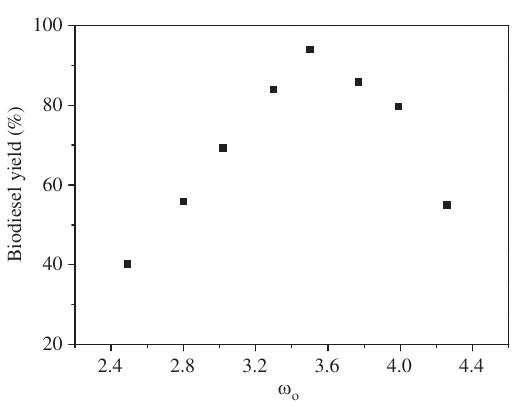
(molar ratio of water to surfactant) on biodiesel Figure 1 Effect of w 0 yield [reaction conditions: lipase 4.4%, molar ratio (methanol/oil) 9, time 16 h, temperature 40 ° C, stirrer speed 250 rpm].